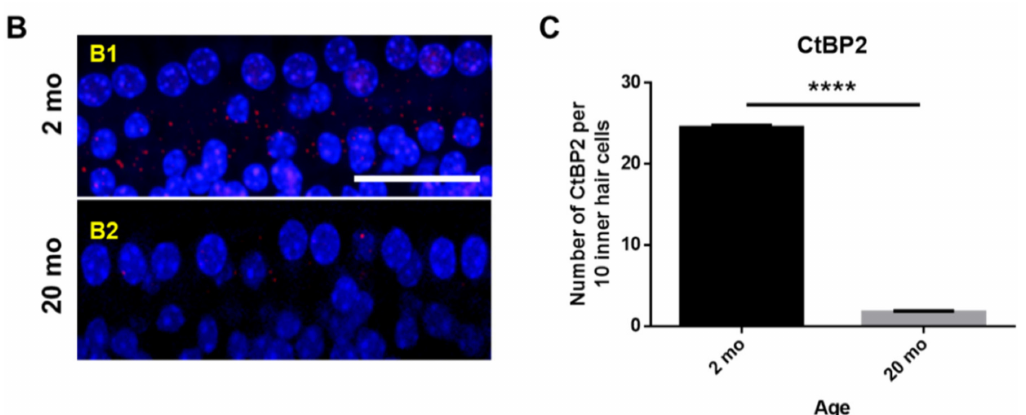
Figure 3. Severe synaptopathy and loss of nerve fibers were observed in aged mice. Whole-mounts of auditory epithelium were triple-stained with Hoechst (blue, nuclear marker, A1 and A2 ), NF-H (green, neuronal cell marker, A3 and A4 ) and CtBP2 (red, a marker of synaptic ribbons, A5 and A6) to evaluate synaptopathy ( A5 and A6 , merged). ( A1,A3 , A5 ) Hair cells (blue) and neurons (green) remain intact in young mice. ( A2 , A4 , A6 ) Neuronal filament in auditory epithelium (green, A4) are notably destroyed in the aged mice. ( B ) Many of the IHC and OHC (blue, Hoechst) are significantly diminished in aged animals compared to young mice. ( C ) Number of presynaptic marker (CtBP2, red) per 10 hair cells was quantified. Aging mice had a significant decrease in CtBP2 counts as compared to the young, indicating significant loss of a marker of synaptic ribbons in aging animals. Scale bar = 30 µ m. Graphs represent mean ± S.E.M. **** p < 0.0001. Unpaired t -test. n =